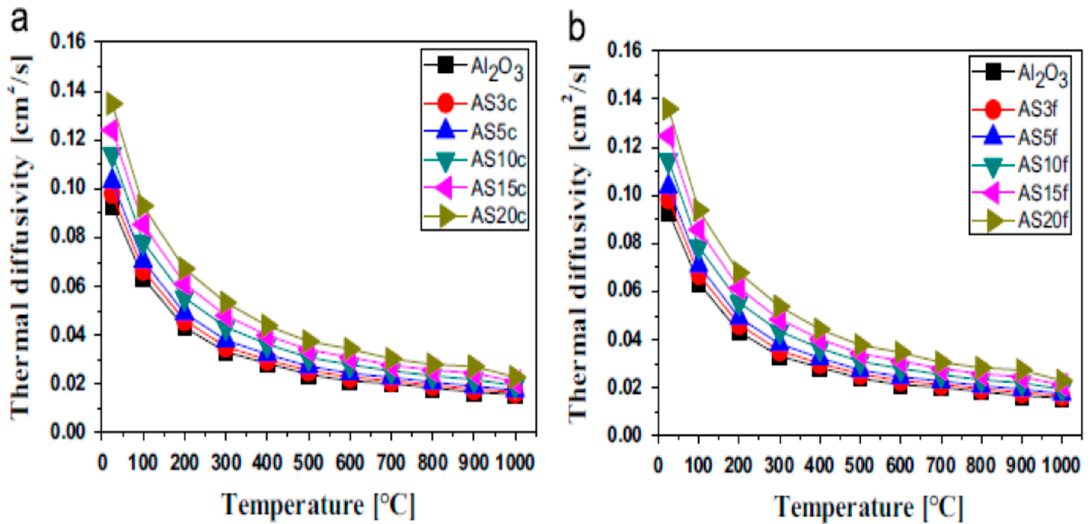
Figure 9. Thermal diffusivity vs measurement temperature: ( a ) nanocomposites AS X c ; ( b ) composites AS X f (f = fine, c = coarse). Reproduced with permission from [85]. Copyright Elsevier, 2014.